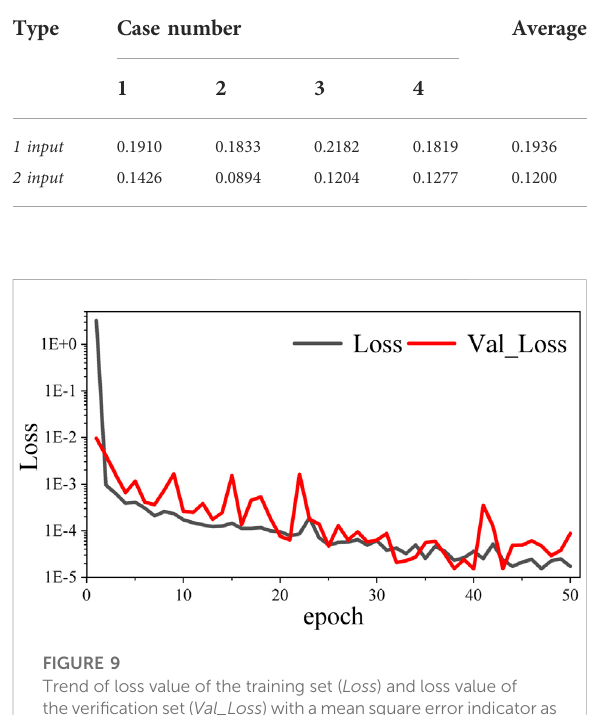
FIGURE 9 Trend of loss value of the training set ( Loss ) and loss value of theveri fi cationset( Val_Loss )withameansquareerrorindicatoras the loss function in the 2 input mode with